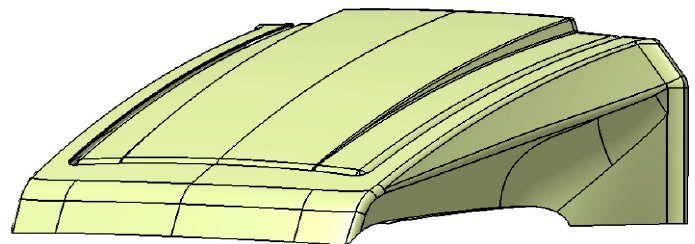
Figure 6. The aerodynamic design result of the final 3D fairing.